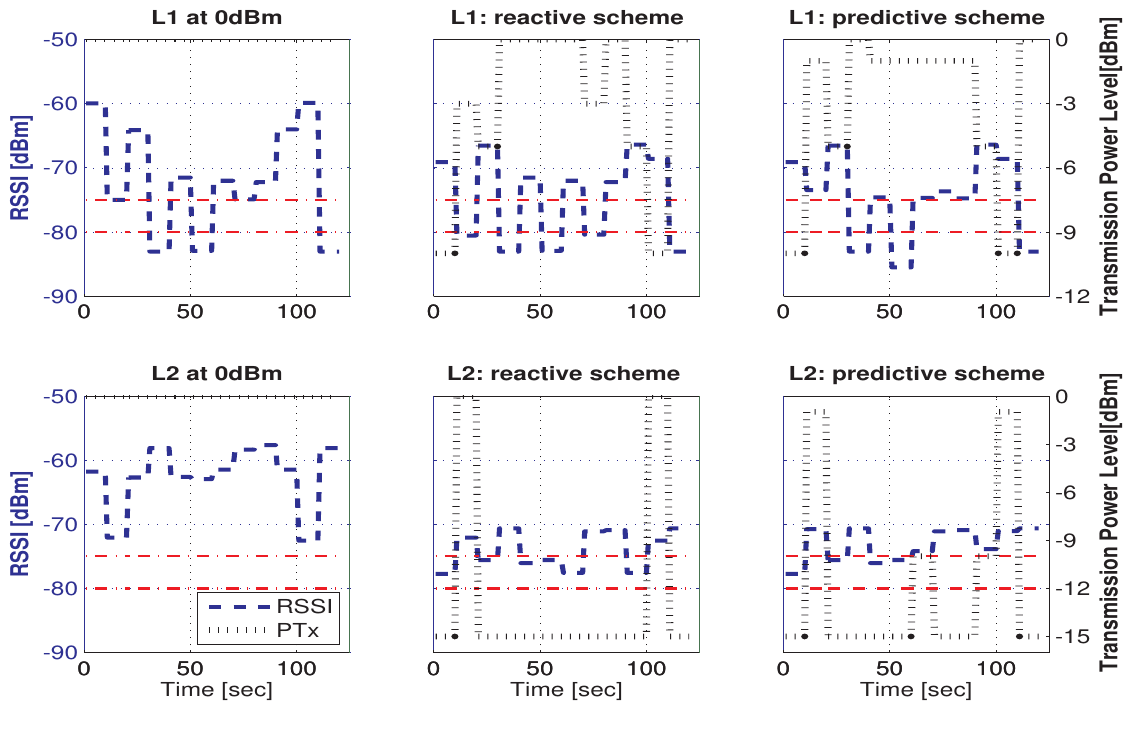
Figure 6. Transmission power and associated RSSI under maximal, reactive and predictive